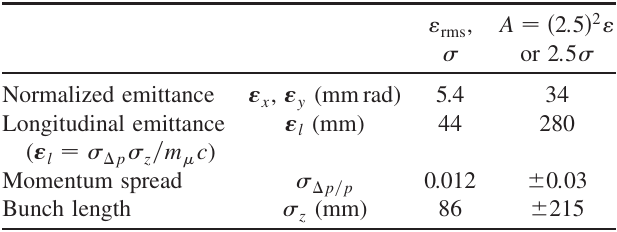
TABLE IV. Beam parameters at the end of the 4 GeV accel- eration system.